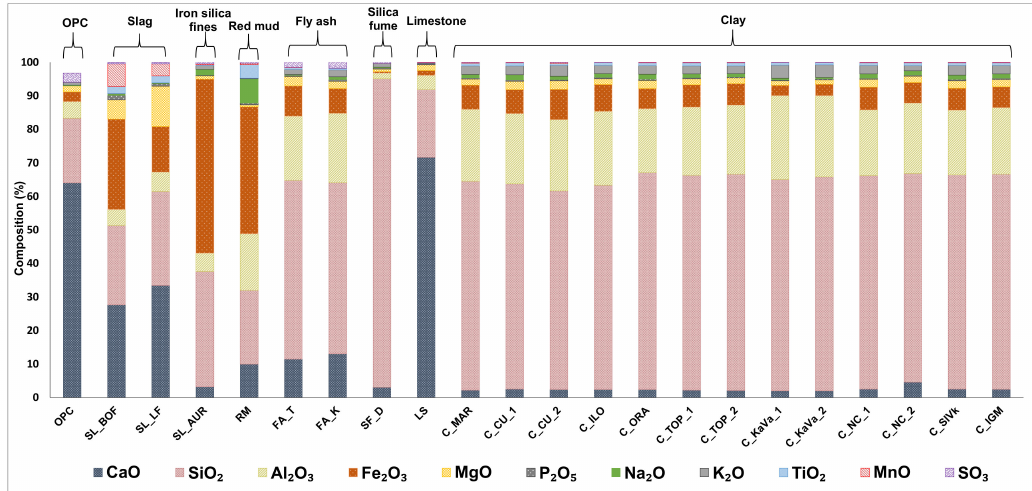
Figure 2. Chemical and physical characteristics of collected raw materials with limitations according to the European standard for fly ash for concrete EN 450:1.